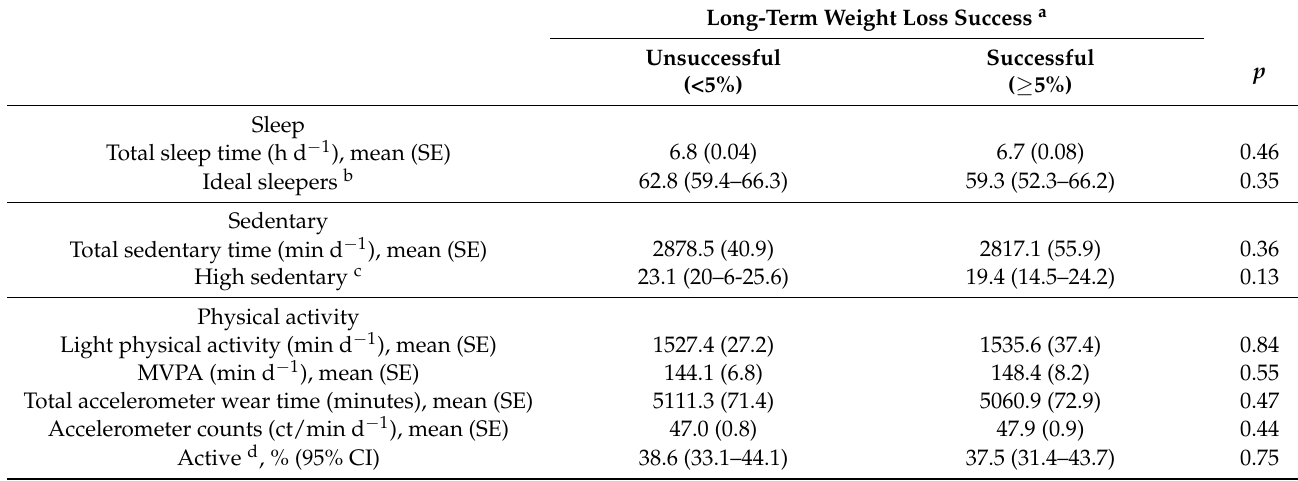
Table 2. Comparison of estimates of sleep, sedentary time, and physical activity by long-term weight loss groups. Long-Term Weight Loss Success a